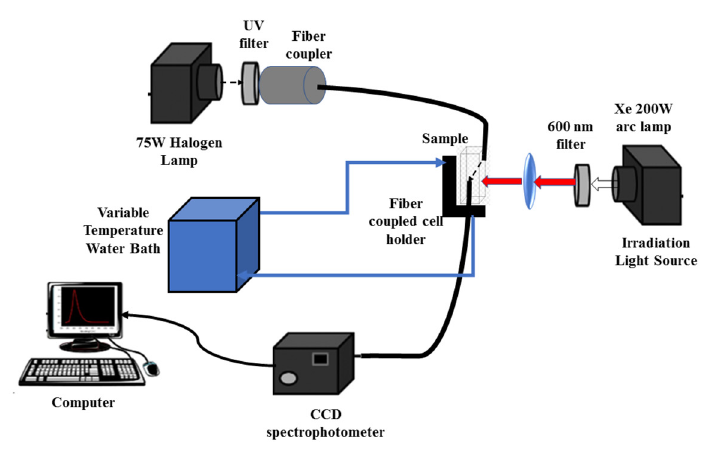
Scheme 1. Representation of the photothermal effect measurement setup.